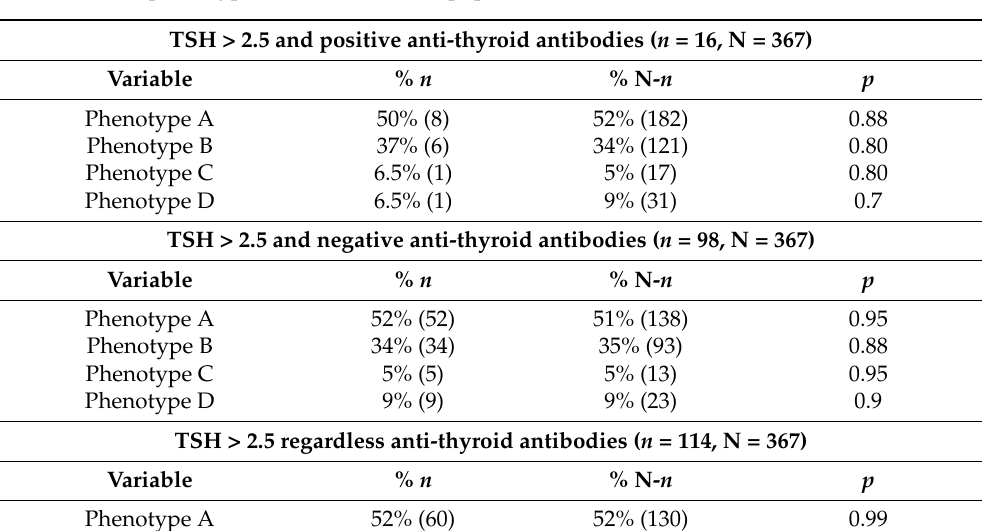
Table 4. PCOS phenotypes in the studied subpopulations of PCOS